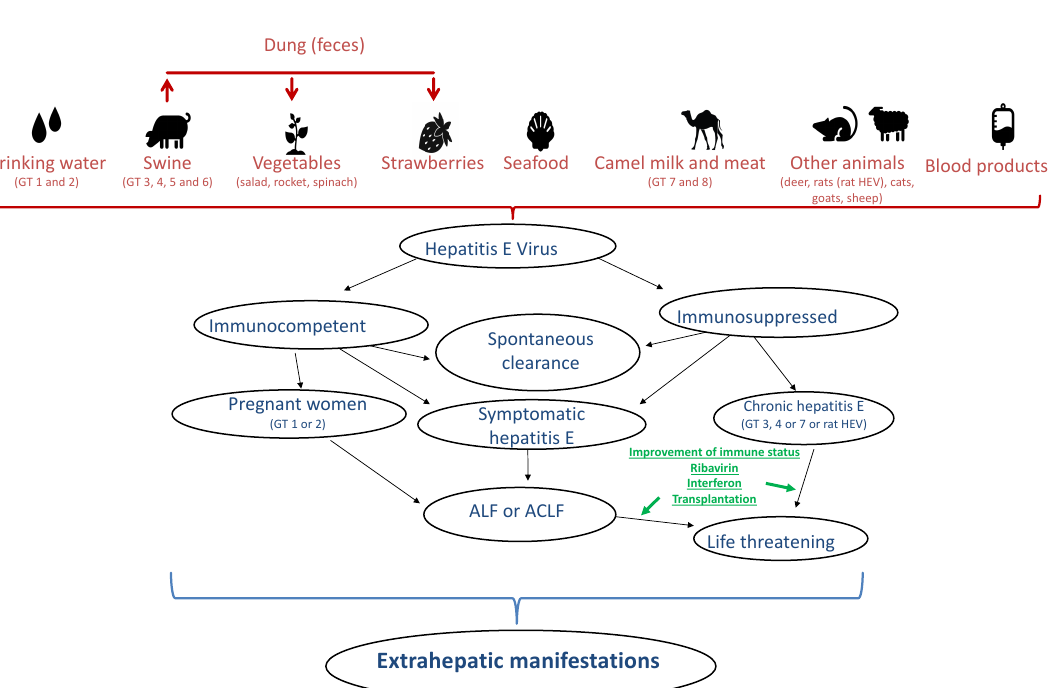
Figure 1. Di ff erent sources and routes of infection and course of disease in immunocompetent and immunosuppressed individuals.